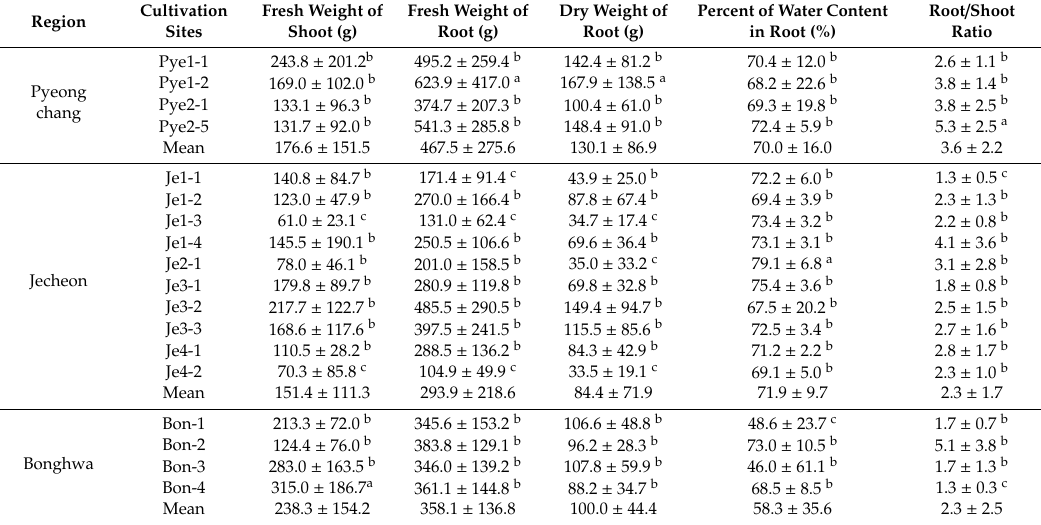
Table 3. Growth characteristics of roots in Angelica gigas cultivation sites, Korea (mean ± SD). Region